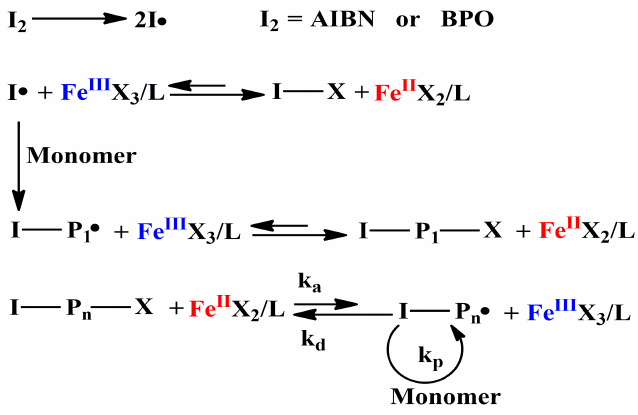
Figure 2. Mechanism of reverse ATRP catalyzed by iron(III) catalyst.